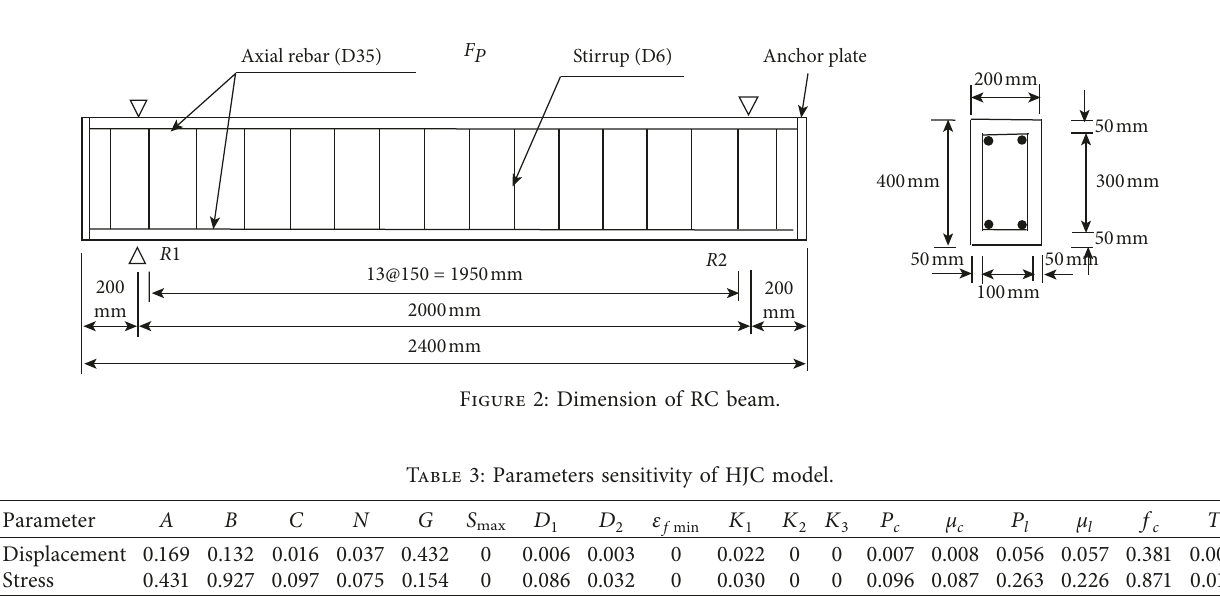
Figure 1: Scheme of numerical test for sensitivity analysis.